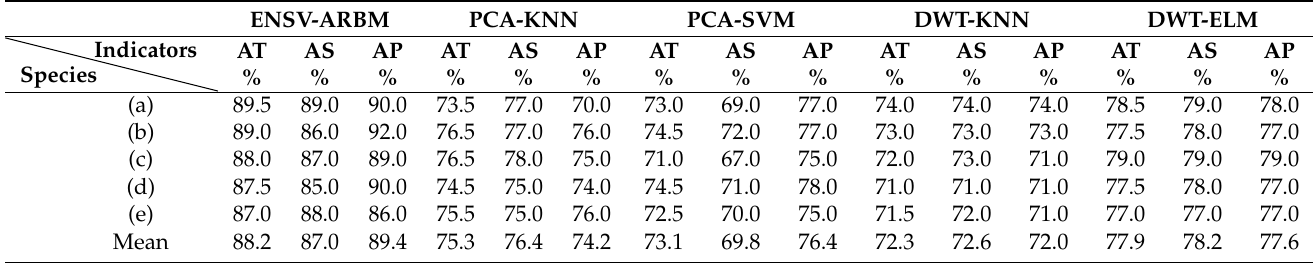
Table 3. Comparison of results between the proposed scheme and other tactile methods.